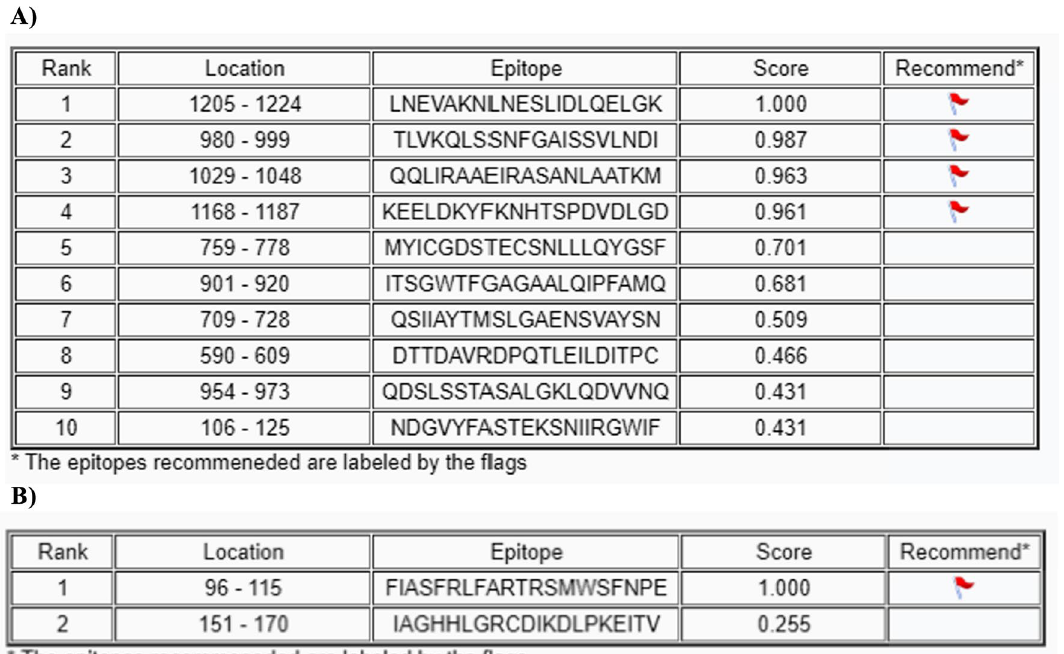
Table 2 Prediction of a ntigenic epitopes sites present in spike (S) protein (A) and M protein (B) surface of